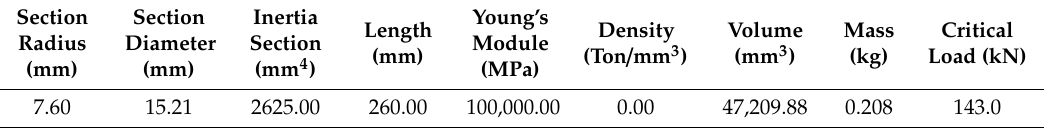
Table 6. Buckling load of reference solid Table 6. buckling load of reference solid structure.